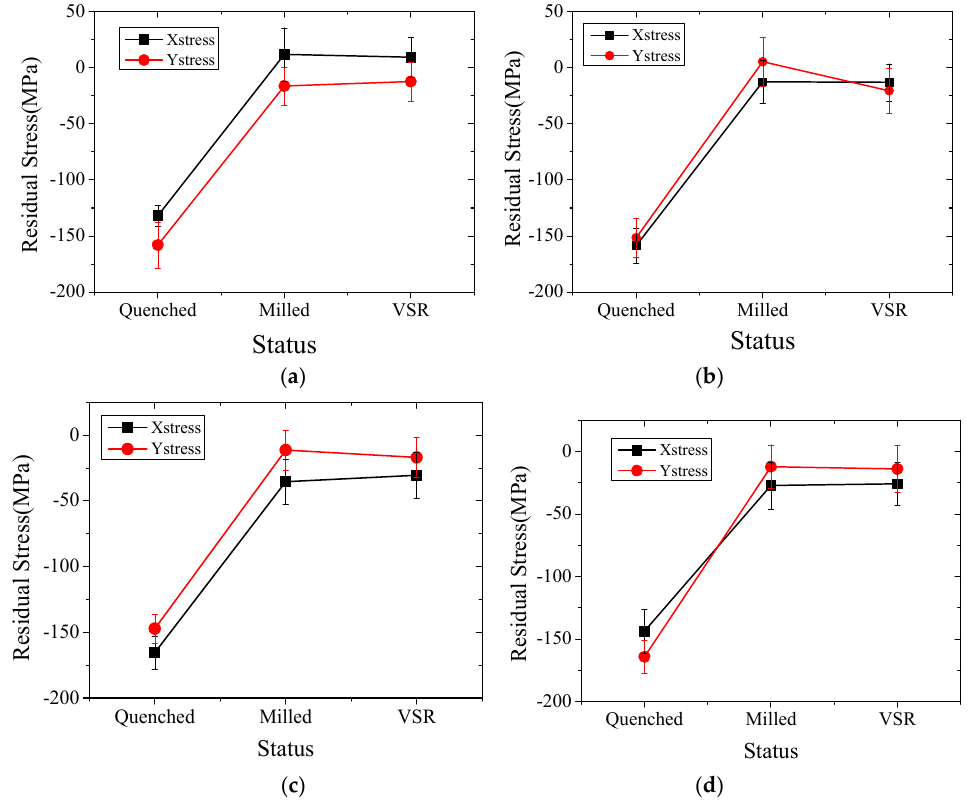
Figure 12. Surface residual stress evolution of sample ( a ) A, ( b ) B, ( c ) C and ( d ) D.